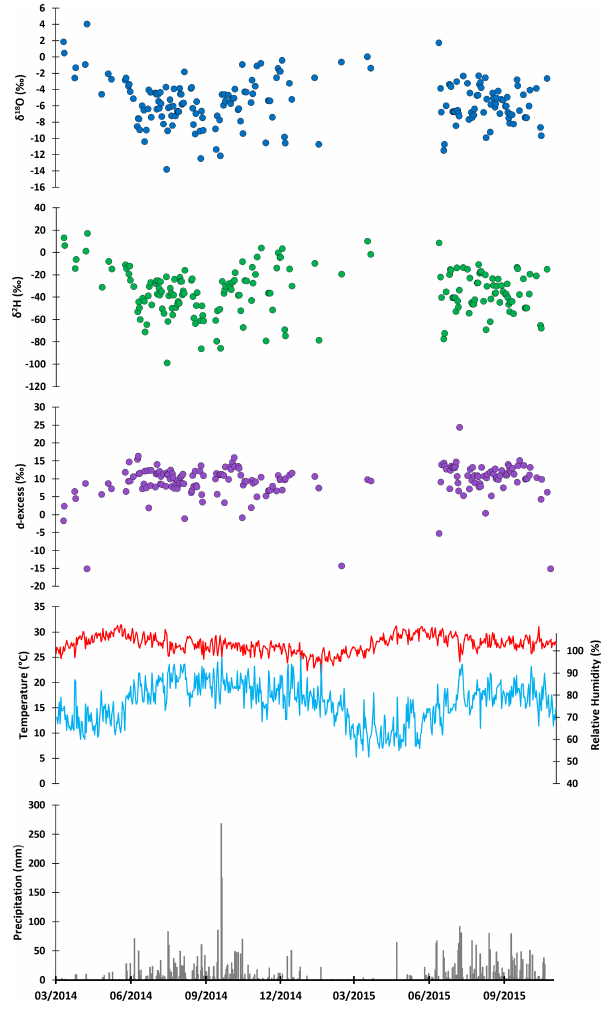
Figure 2. Time series of daily variations of δ 18 O, δ 2 H, d- excess, temperature, relative humidity, and precipitation amount at Metropolitan Manila, Philippines. Please note that the date format in this figure is